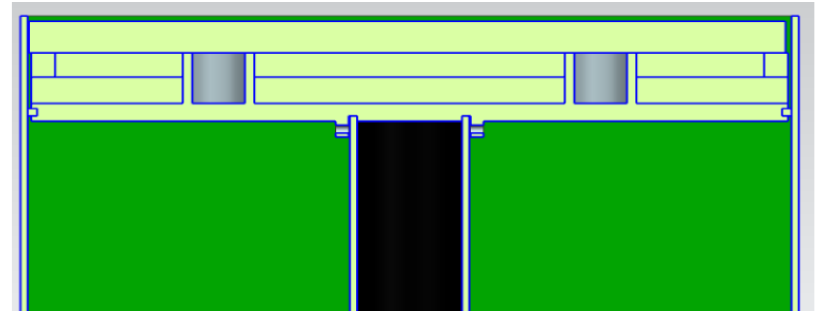
Figure 12. 3D view of QuickPre preheating concept.